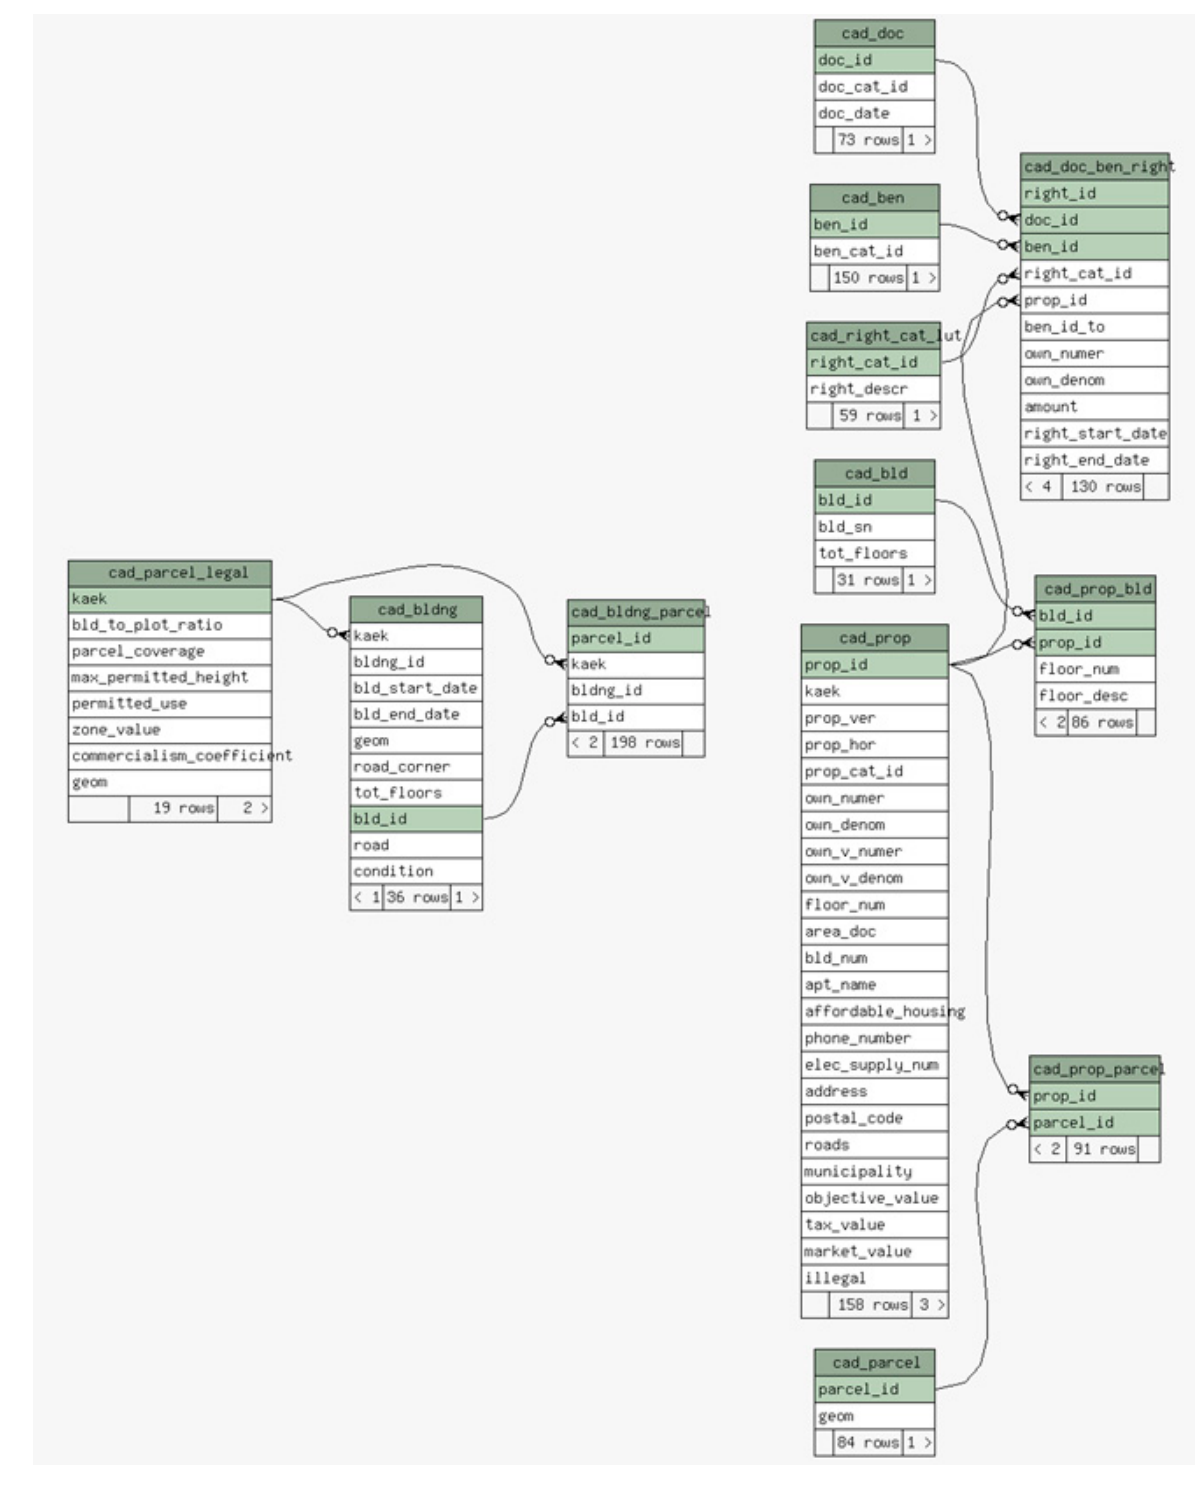
Figure 2. Entity relationship diagram showing the proposed structure of the external database.